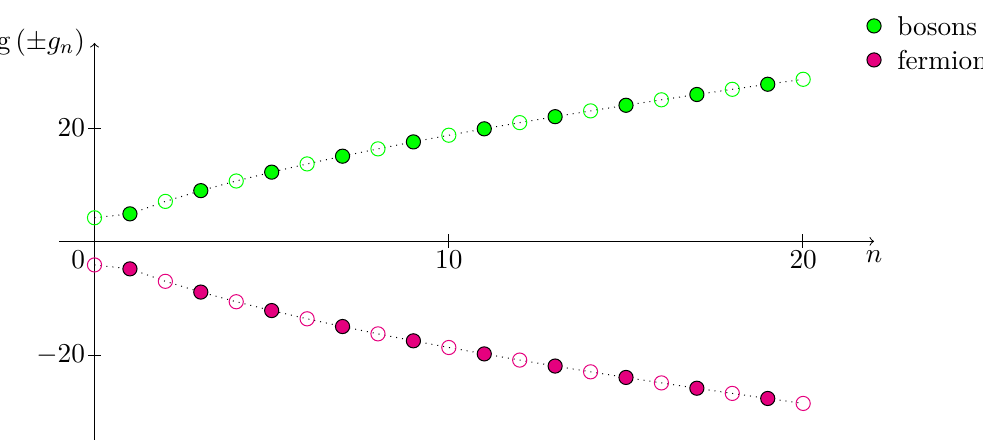
Figure 2 . The number of bosonic and fermionic physical degrees of freedom for the lightest energy levels for a D p -brane on top of an O p -plane, defined as ( − 1) F n g = N ( n ) − N ( n ) . Each point n b f corresponds to states with mass M 2 = n/α 0 , with n = 0 , 1 , . . . , 20 . Filled points correspond to n states that are invariant under the orientifold projection, whereas empty dots represent states that would be there if the D p -brane was at a smooth point but that are projected out by the orientifold. The number of bosonic and fermionic states is the same at each mass level and the partition function vanishes as required by supersymmetry.